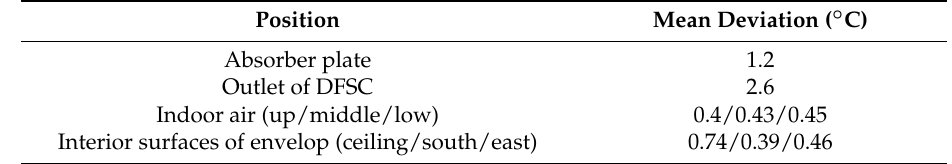
Table 3. The mean deviations of temperature obtained through numerical simulation and